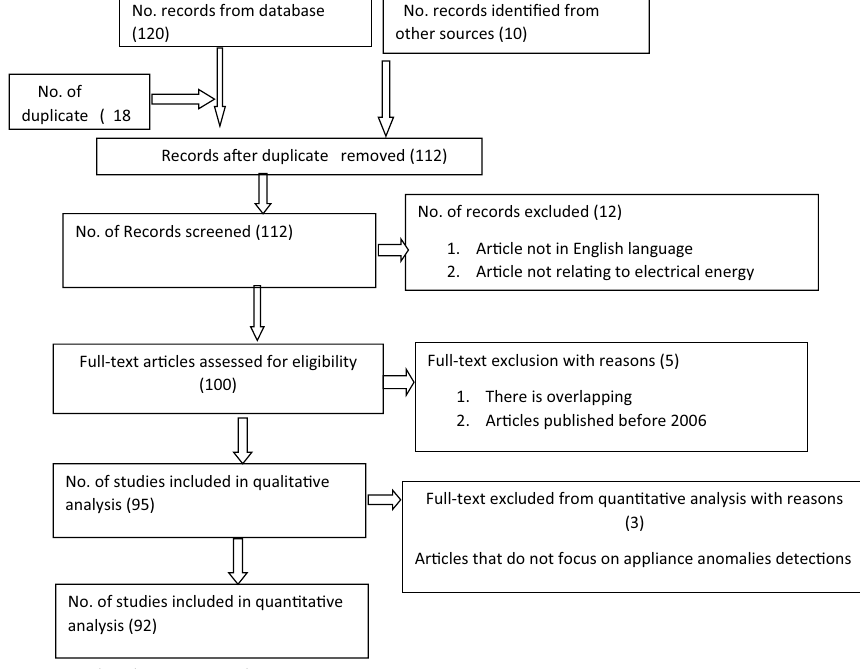
Fig. 1 Article selection procedure (PRISMA)